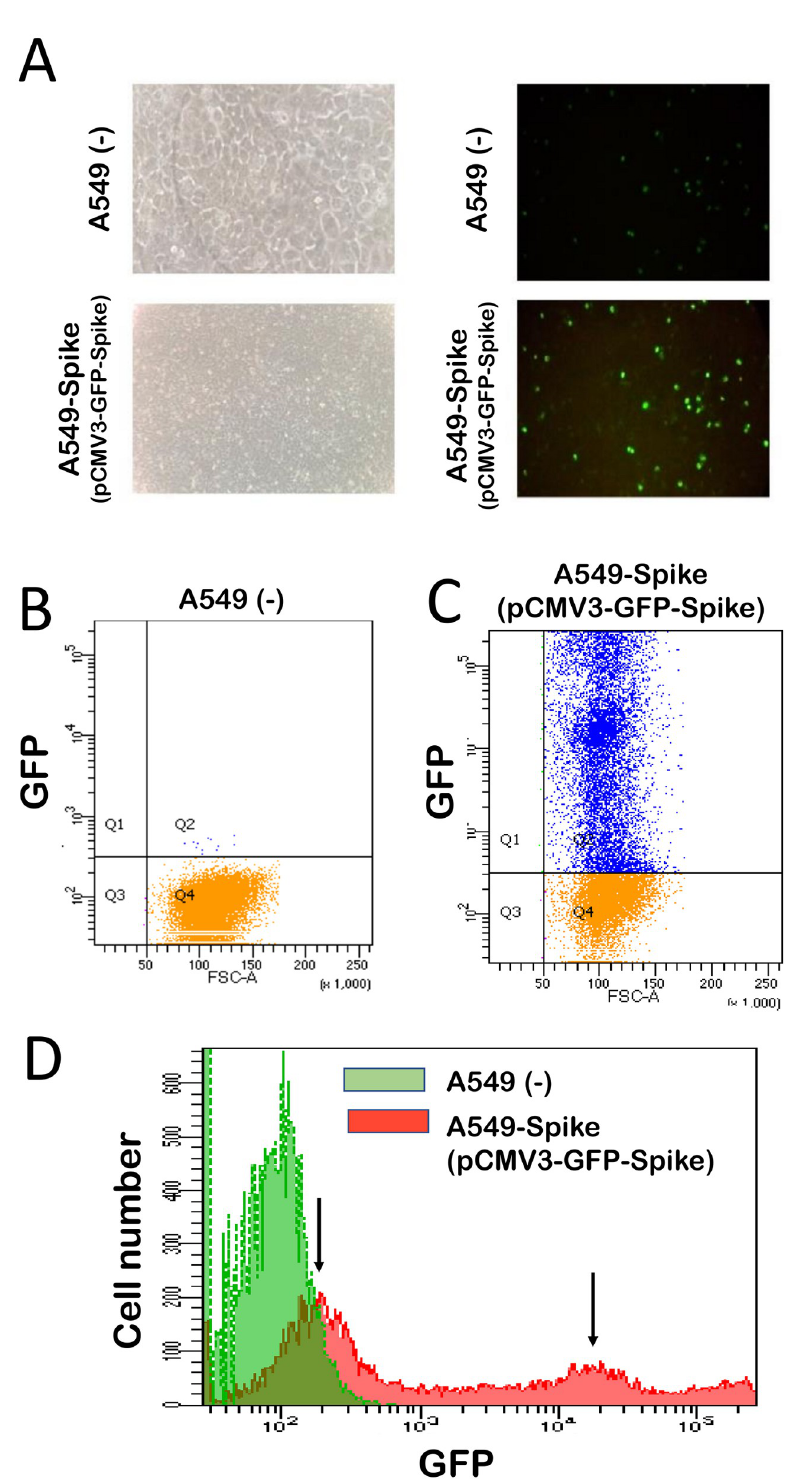
Fig 2. Preliminary activity (see Fig 1A): Characterization of untreated A549 cells and A549 cells transfected with the pCMV3-GFP-Spike plasmid. A. Microscopy-based analysis. On the bottom-right side of this panel a fluorescence analysis is shown demonstrating high number of fluorescent A549-Spike cells. B,C. FACS analysis of untreated (B) and pCMV3-GFP-Spike plasmid treated (C) A549 cells. D. Densitometry analysis of the FACS profiles shown in B and C, demonstrating that all the A549-Spike cells are fluorescent, but at least two populations are present, identified by black arrows (red histogram).